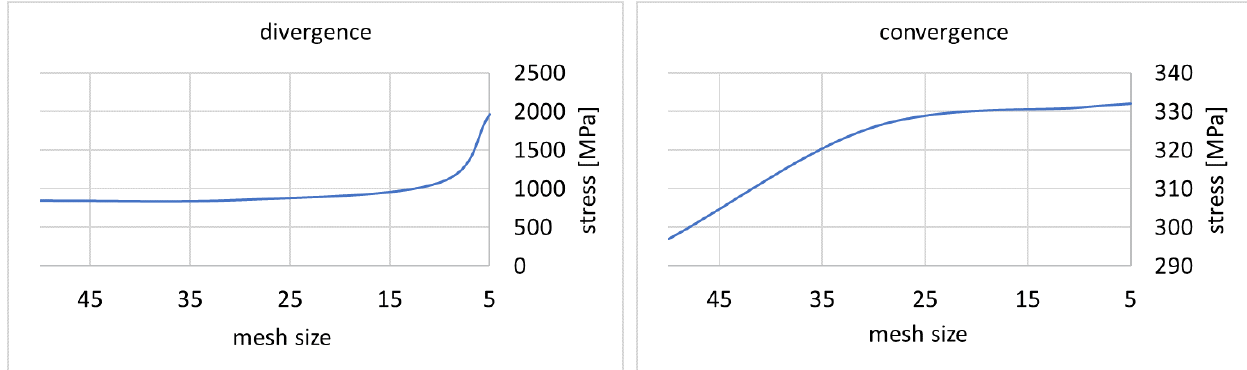
Figure 16. Convergence and divergence behavior for different mesh